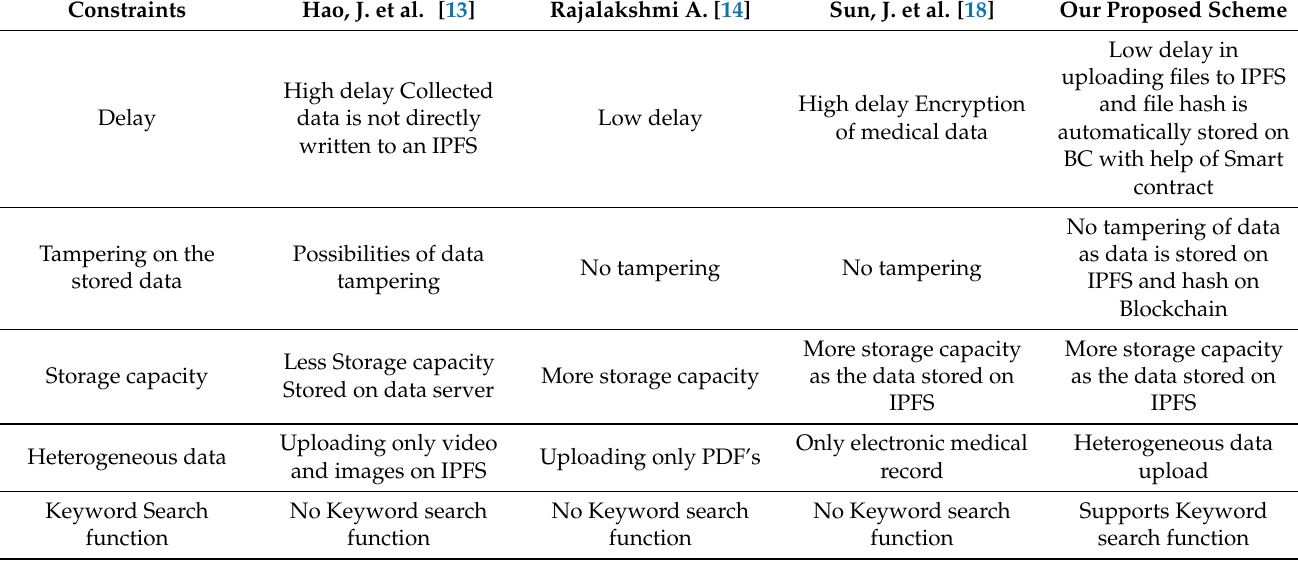
Table 1. Comparison of existing approaches with the proposed